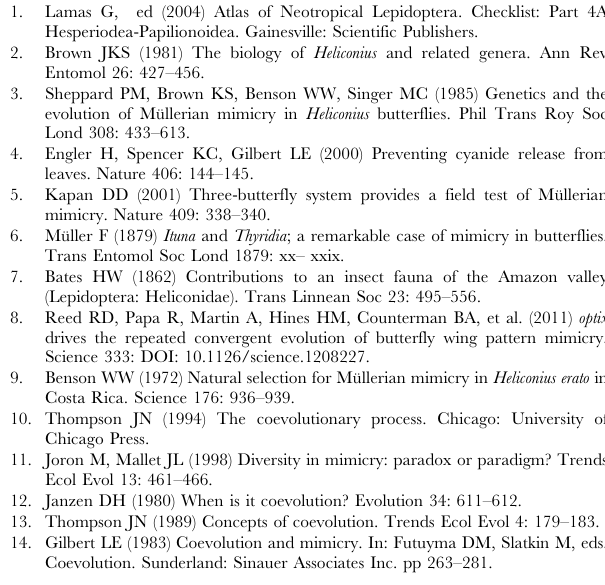
(abbreviations correspond to Figure 2 with additional abbrevia- tion: B Brazil). Further annotation corresponds to Figure S5. (EPS) Figure S7 Phylogenies reconstructed as for those of Figure S6 except based on only the 5 colour pattern genes of [22] and corresponding to cophylogenetic analysis ‘‘Hines et al. 2011 colour pattern genes’’ in Table 1. Further annotation corresponds to Figure S5. Figure S8 History of mimicry between H. erato (black phylogeny) and H. melpomene (blue phylogeny), reconstructed using Jane 3, based on the phylogeny shown in Figure S1: white-filled circles represent codivergence, solid circles represent duplications, arrows represent model switches, and dashed lines represent losses. Table S1 Sampling information for the study system, including accession numbers. (XLS) Table S2 Significance of congruence between phylogenies with a model (here H. melpomene ) to mimic (here H. erato ) relationship, reversed relative to Table 1. Table S3 DNA sequences used in this study: aligned data matrix in Nexus